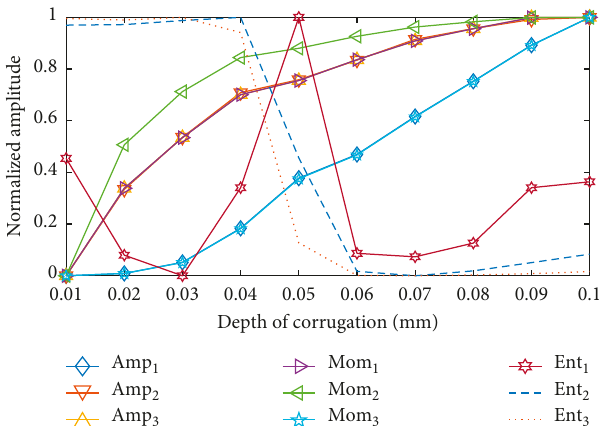
Figure 11: Bispectrum features at different depths of corrugation (train speed is 250km/h and wavelength is